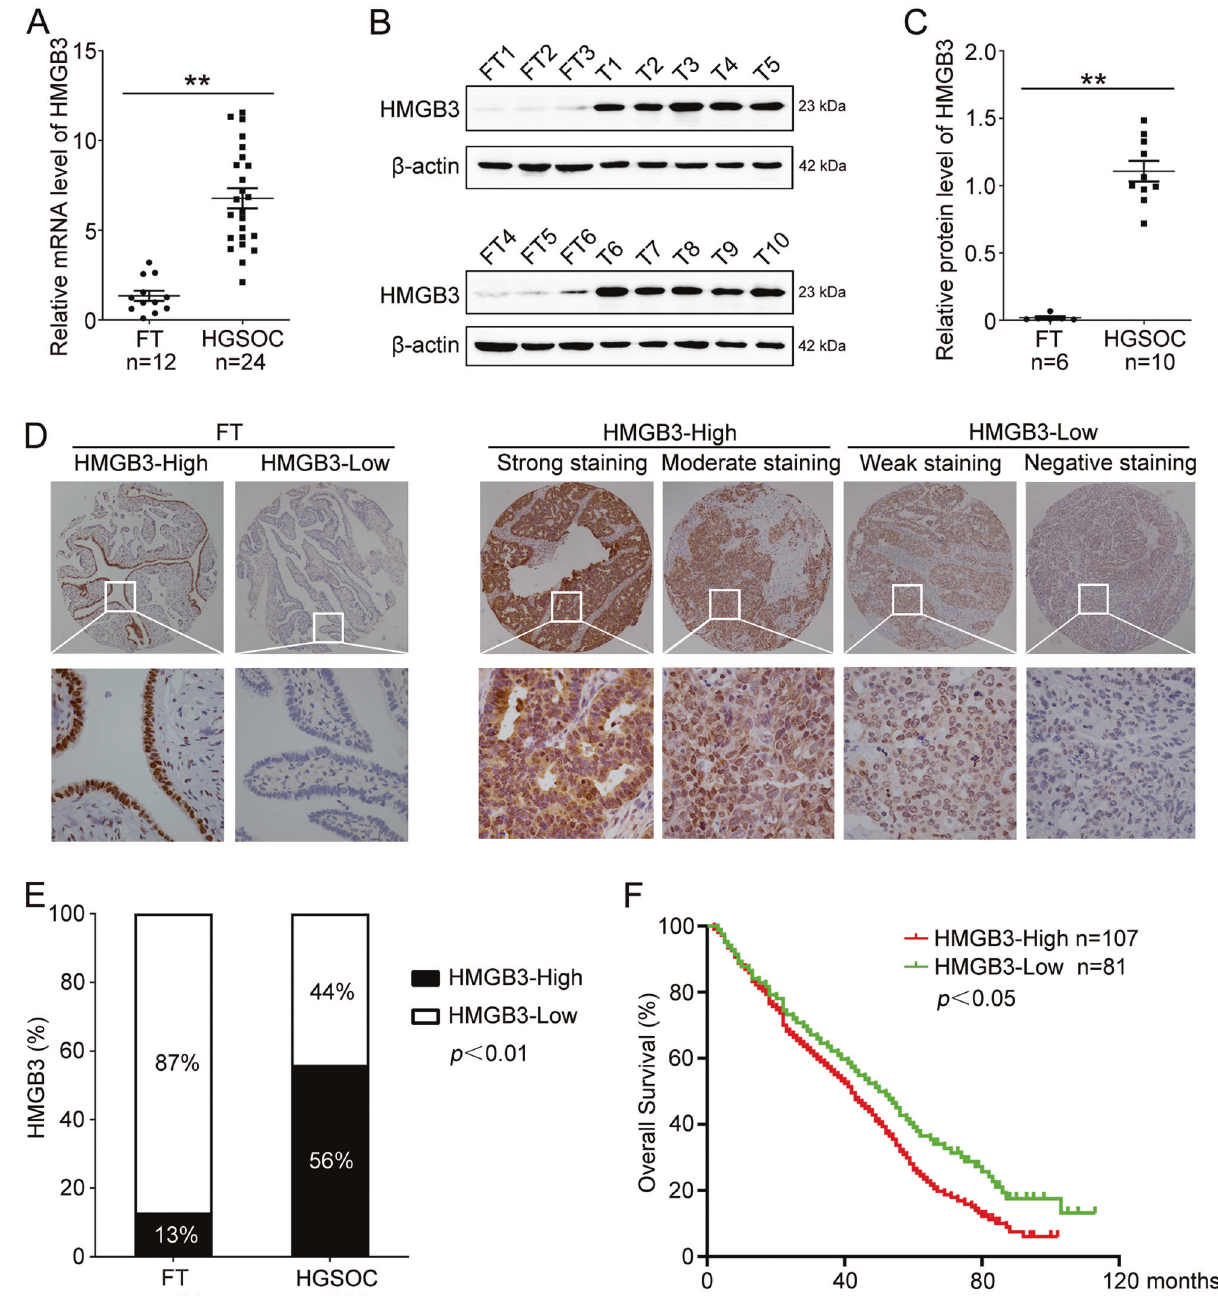
Fig. 1 HMGB3 is highly expressed and correlated with poor prognosis in HGSOC. A qRT-PCR was performed to detect the mRNA levels of HMGB3 in high-grade serous ovarian cancer (HGSOC) tissues and normal fallopian tube (FT) tissues (FT, n = 12; HGSOC, n = 24). B Western blot was used to determine the protein levels of HMGB3 in FT and HGSOC tissues (FT, FT1-FT6; HGSOC, T1-T10). C Quanti fi cation of HMGB3 protein levels in ( B ). D Immunohistochemistry (IHC) staining of HMGB3 in FT tissues and HGSOC tissues. Representative images are shown (Upper, 40×; Lower, 400×). E Quanti fi cation of HMGB3 expression in FT tissues ( n = 54) and HGSOC tissues ( n = 234). F Overall survival (OS) curves of HGSOC patients with high or low HMGB3 levels. (Data are presented as the mean ± SEM, # p > 0.05, * p < 0.05, ** p < classi fi ed as having a high expression rate (HMGB3-High) HMGB3 is overexpressed in ovarian cancer tissues compared with compared with only 13% of FT samples (Fig. 1D, E). Patients with control tissues (Fig. S1B – F). Consistently, our results also showed HMGB3-High showed signi fi cantly shorter OS than patients with that the HMGB3 mRNA and protein levels in HGSOC tissues were low HMGB3 expression (Fig. 1F). Moreover, the clinicopathological extremely upregulated relative to those in normal FT tissues characteristic analysis found that HMGB3-High was associated (Fig. 1A – C). To explore the clinical signi fi cance of HMGB3 in with lymph node metastasis and platinum resistance in HGSOC patients with HGSOC, IHC staining was performed in HGSOC and patients (Table 1), indicating that HMGB3 might play a vital role in FT tissues. HMGB3 was highly expressed in HGSOC tissues the development of chemoresistance in ovarian cancer. compared with normal FT tissues, with 56% of HGSOC samples